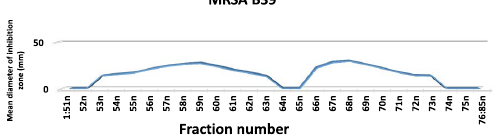
Fig. 6. Fractionation pattern of active antimicrobial substance from E. hirta ( EH) extract and their effect against MRSA,